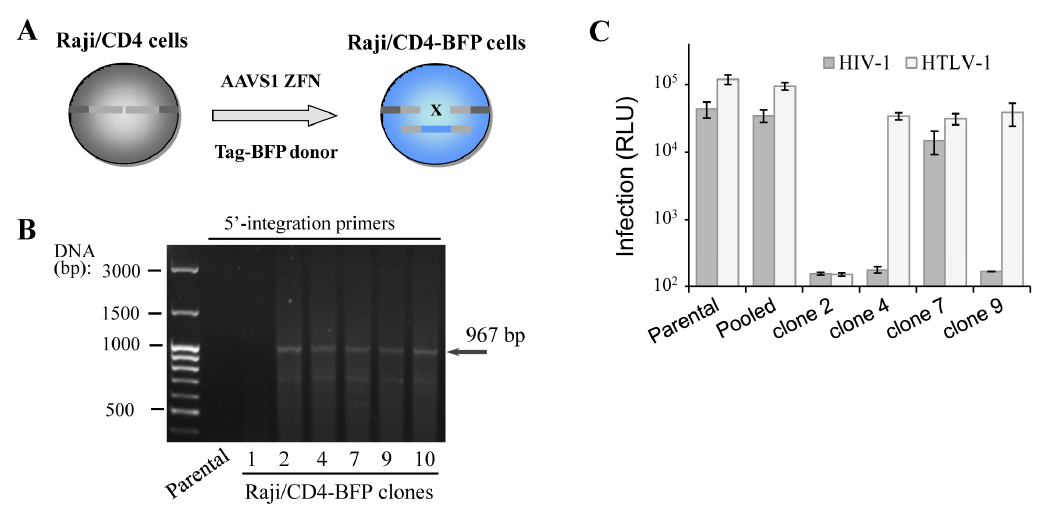
Figure 2. Functionality of gene-edited cells selected via cloning or sorted as pooled population. ( A ) schematic representation of Raji/CD4 cell generation with Tag blue fluorescent protein (Tag-BFP) engineered using ZFN; ( B ) PCR with 5 (cid:48) -integration-specific primers to determine whether the integration of the Tag-BFP expression cassette at the AAVS1 locus of isolated Raji/CD4 clones is correct; ( C ) quantification of HIV-1 and HTLV-1 cell coculture levels of infection in Tag-BFP clones and in the sorted population. CEM cells were transfected to initiate HIV-1 or HTLV-1 infection as outlined in Methods, and mixed with the parental Raji/CD4 cells (control) or Tag-BFP + cells selected as a pool or clones. Three days later, cells were lysed, and the levels of infection were estimated by measuring the levels of luciferase activity. Data are representative of at least three independent